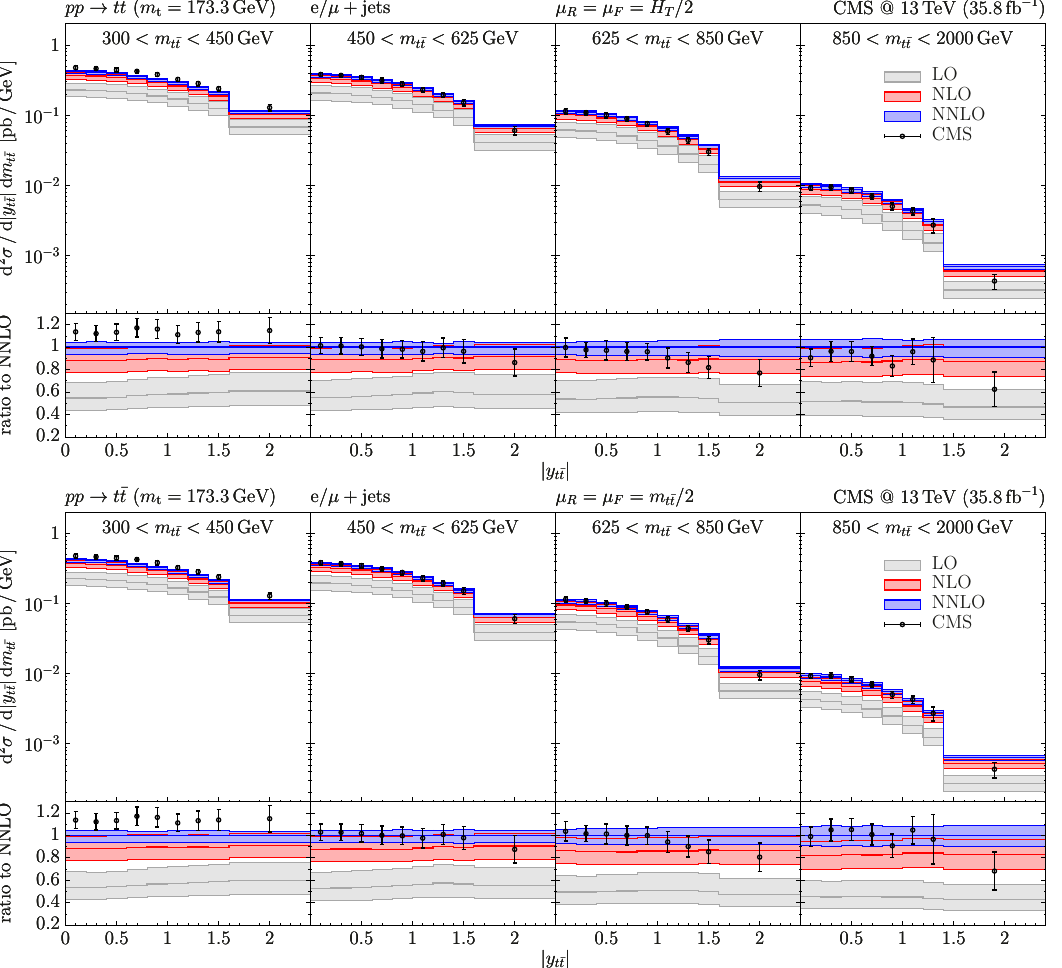
Figure 6 . Double-di(cid:11)erential cross sections as a function of y and LO, NLO and NNLO results for central scales H T = 2 (upper) and m t (cid:22) t = 2 (lower). with those for the single-di(cid:11)erential cross sections in (cid:12)gures 4 and 5. The impact of the radiative corrections is relatively uniform in y slightly larger radiative corrections in the highest- m